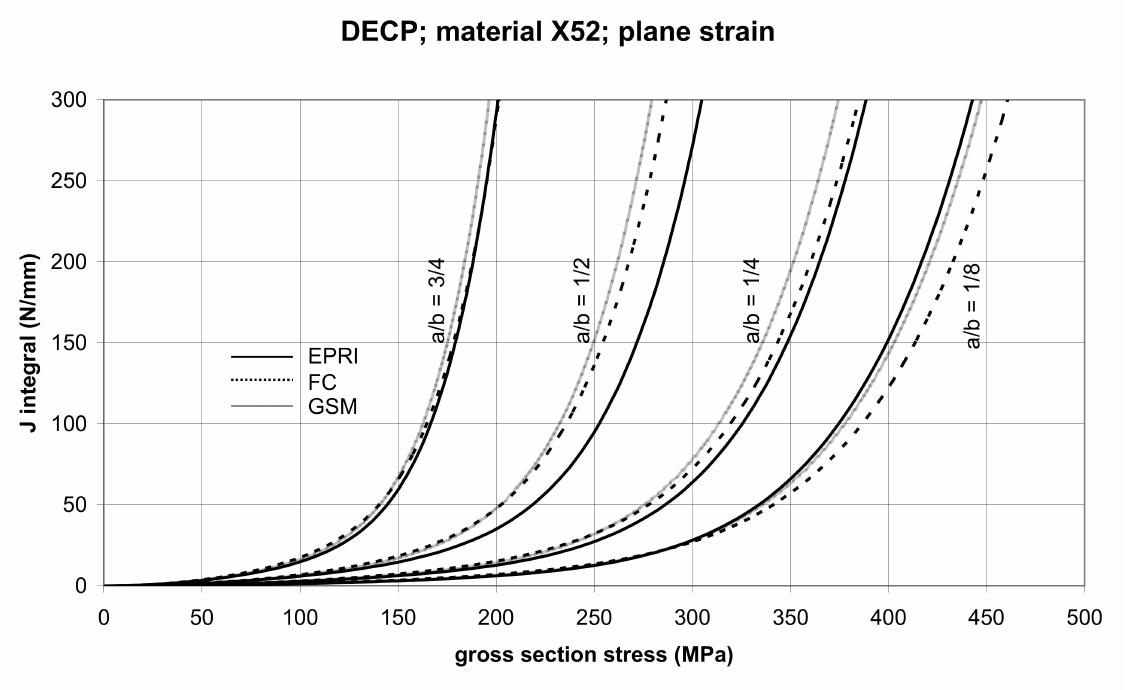
Figure 11. Comparison of J integral for DECP X52 steel specimens in the plane strain condition as determined by the EPRI, GSM, and FC